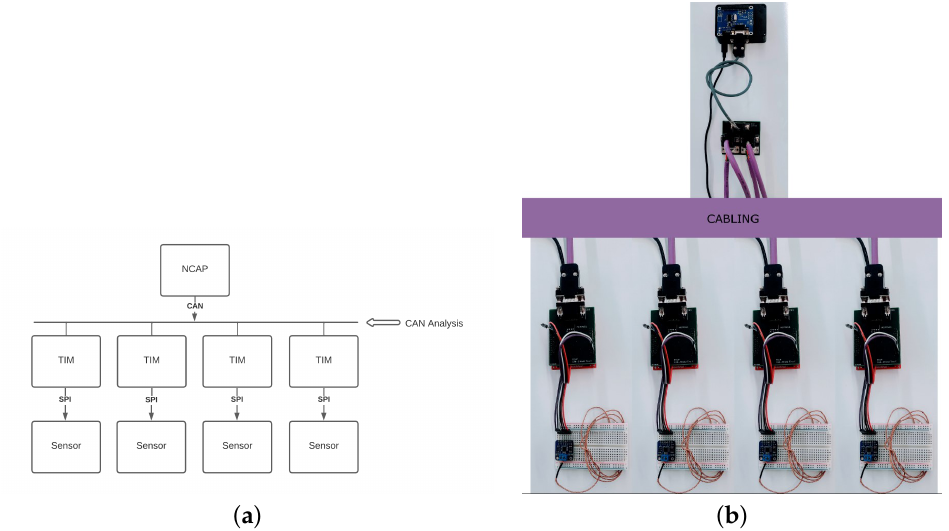
Figure 12. One-to-Many-to-One System: ( a ) Diagram representing one-to-many-to-one system connection; ( b ) Physical representation of the connected one-to-many-to-one